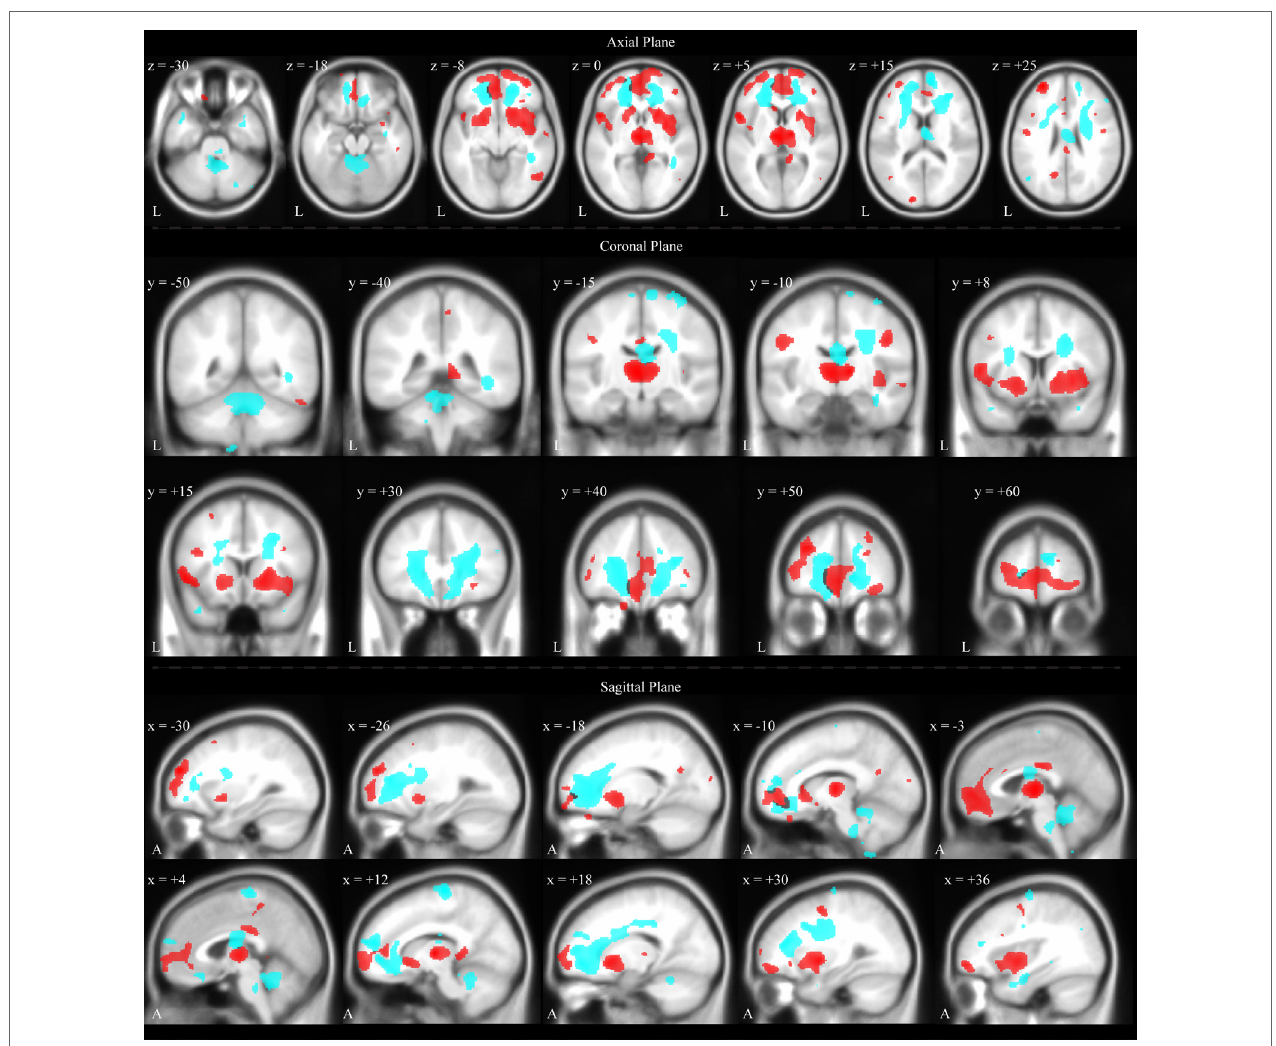
FigUre 4 | Brain areas with significant volume reduction in the TBi group compared to the control group overlaid on an Mni template brain . Gray matter is color-coded red. White matter is color-coded cyan. Results are overlaid onto the MNI152 T1 standard template. Axial views on first row, coronal views on second and third rows, sagittal views on fourth and fifth rows. L, left. A, anterior.